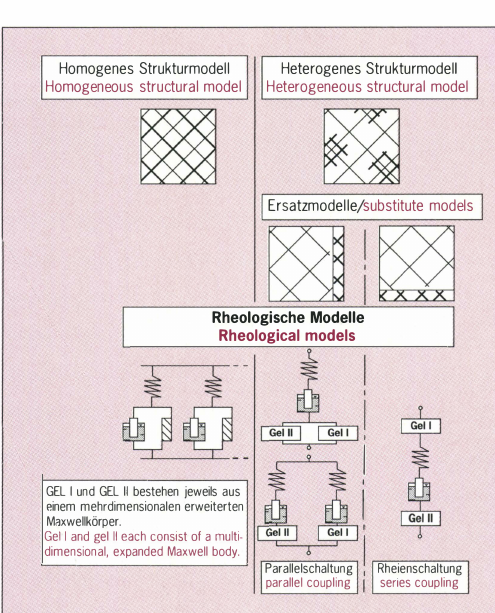
Abb. 8: Qualitativer Zusam­ menhang zwischen den molekularen Strukturen der Losung und der Gele Fig. 8: Qualitative relation­ ship between the molecular structures of solutions and gels